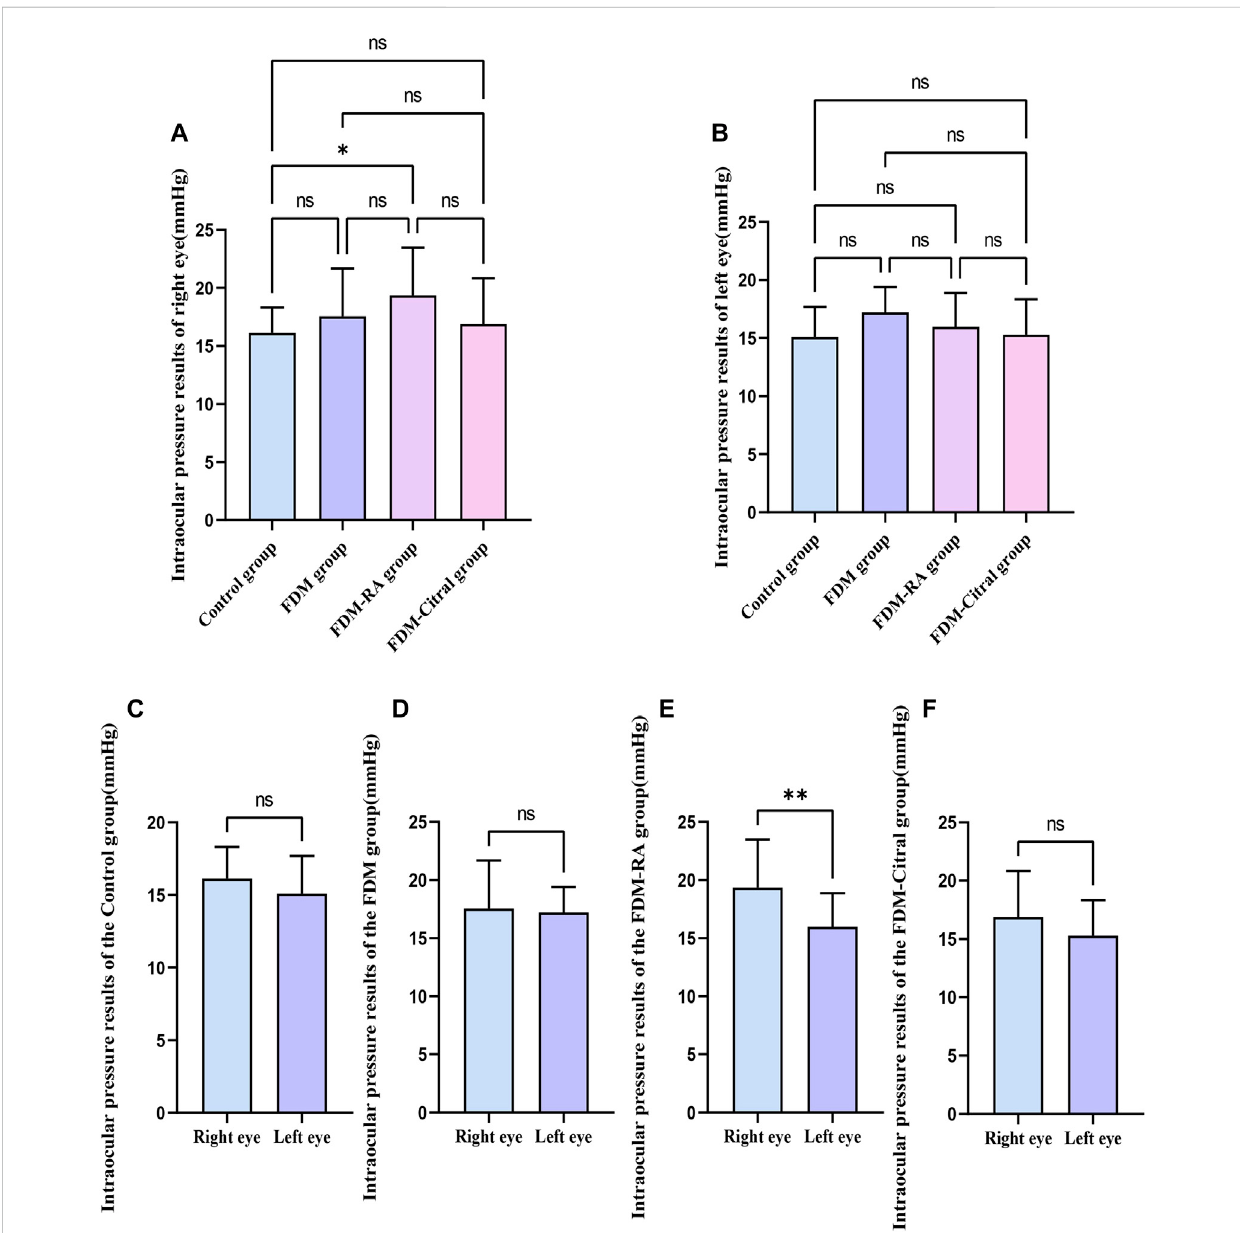
FIGURE 6 Comparison ofIOP in eachgroup (mmHg).Note. (A) , Comparison ofIOP intherighteye; (B) , Comparison ofIOP in theleftteye; (C) , Comparison of IOP between left and right eyes in Control group; (D) , Comparison of IOP between left and right eyes in FDM group; (E) , Comparison of IOP between left and right eyes in FDM + RA group; (F) , Comparison of IOP between left and right eyes in FDM + Citral group; IOP, intraocular pressure; ns means that the difference is not statistically signi fi cant; *Indicates p ≤ 0.05; ** Indicates p ≤